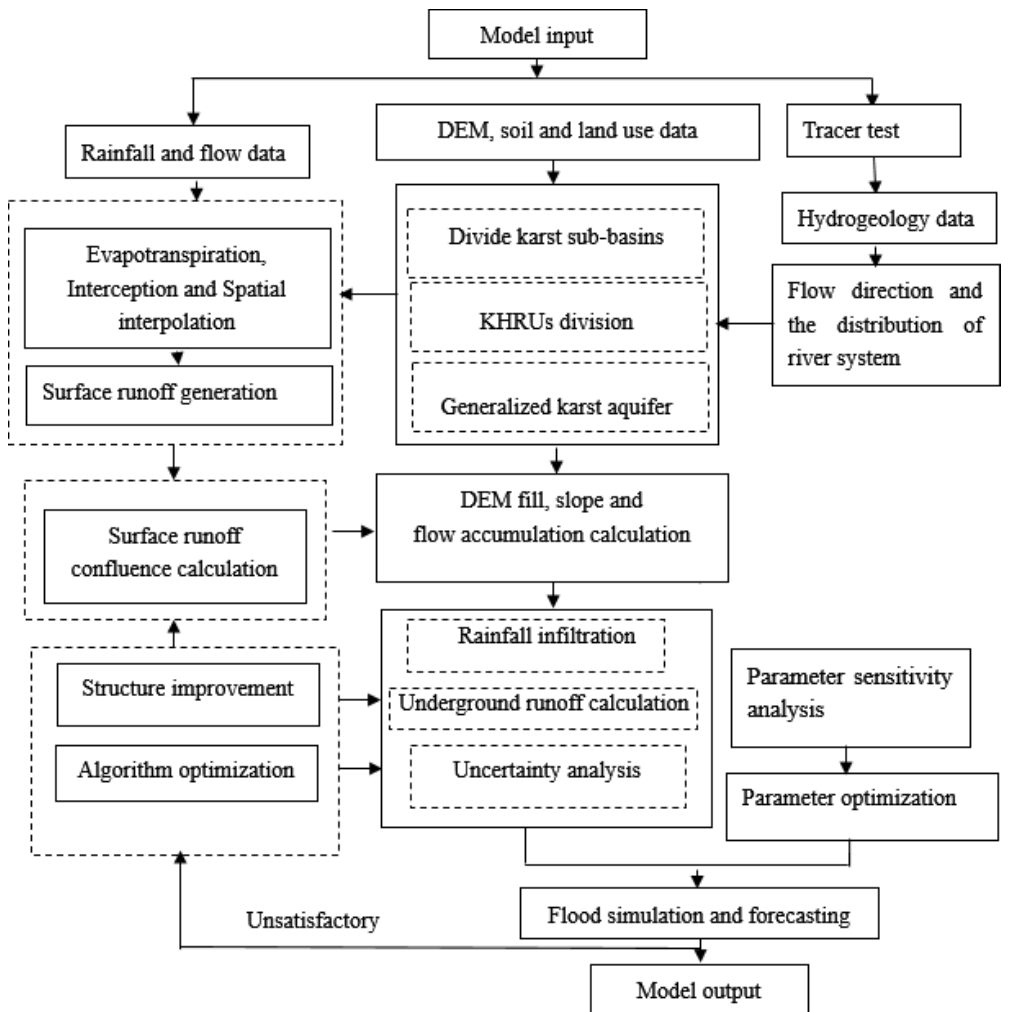
Figure 2. Modelling flow chart of the QMG (Qingmuguan)